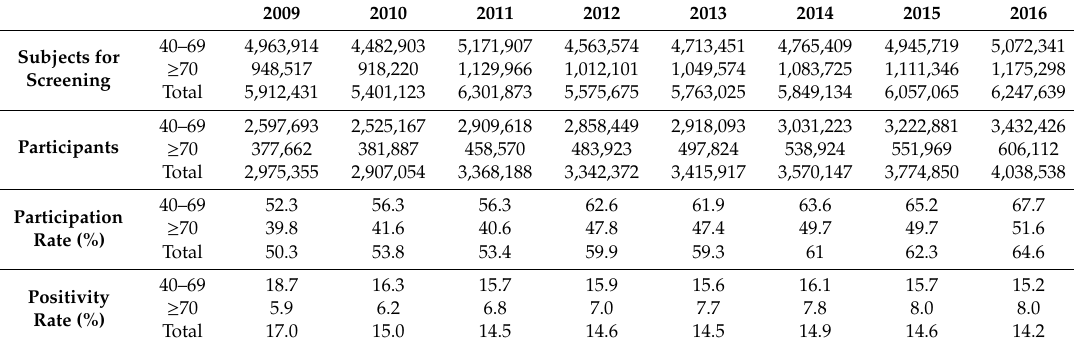
Table 1. Numbers of subjects and participants and rates of participation and positivity, 2009 to